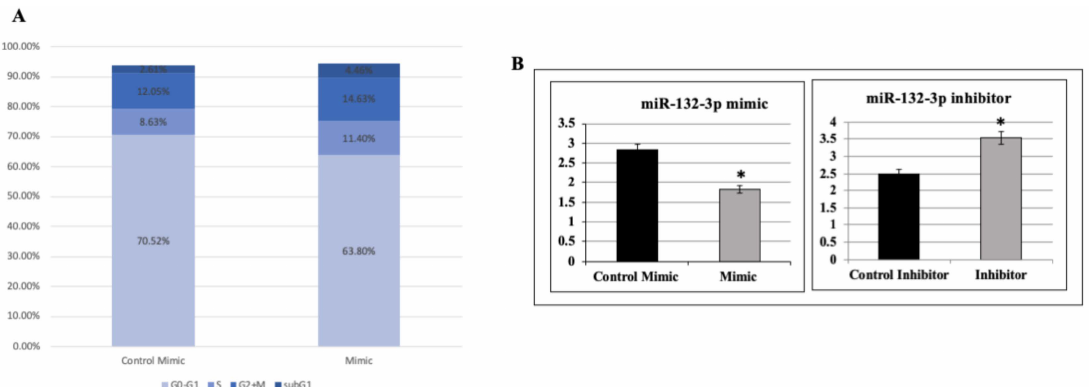
Figure 5. Effect of miR-132-3p on cell cycle progression and proliferation. ( A ) HEK293T cells were transfected with miR-132-3p mimics for 24 h, after which, the proportion of cells in each phase was measured by FACS analysis. ( B ) Cells were transfected with miR-132-3p mimics or inhibitor for 24 h, after which, cell number was assessed using a Cell Counter. * p < 0.01 versus control